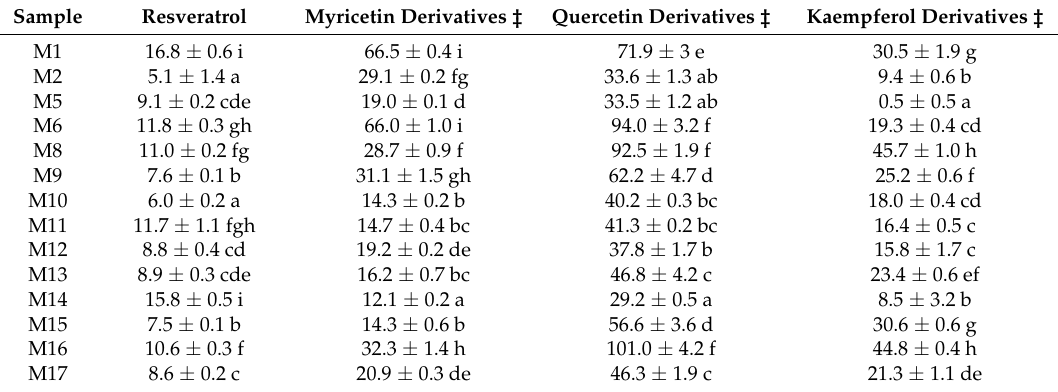
Table 6. Resveratrol and flavonols in berry skins (mg/kg of grape). Values represent mean of three replicates ± SD. a, b, c: the means that do not bear a common letter differ significantly at the 0.05 level of significance. ‡ Sum of two glycosides: glucuronide and